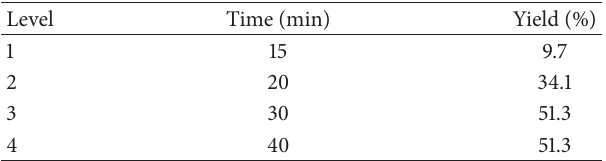
Table 7: Experimental results for synthesis of 𝛽 -(3,4-dihydrox- yphenyl) pyruvic acid at different reaction time periods.